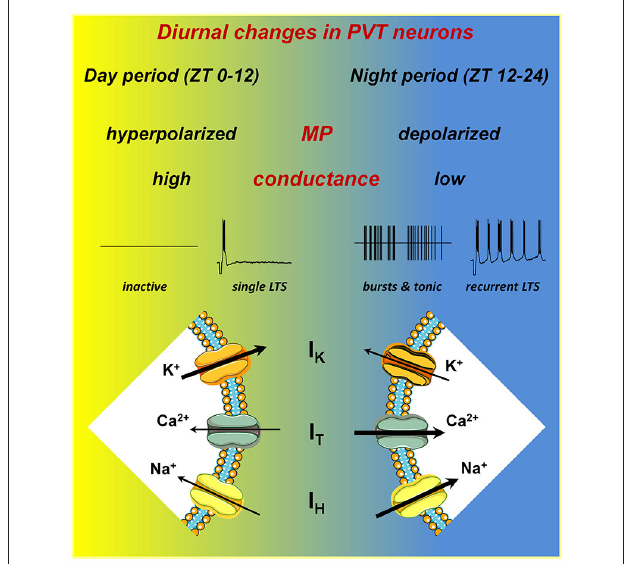
FIGURE 1 | PVT neurons express diurnal changes . A schematic illustrating the differences in intrinsic electrical properties of PVT neurons recorded in slices from different ZT periods. In night period slices, neurons have a more depolarized resting membrane potential (RMP), lower resting membrane conductance, in part owing to lower overall K + currents (I K ), and larger amplitude T-type Ca 2 + (I T ) and hyperpolarization-activated cation (I H ) currents. These changes result in increased spontaneous tonic and burst firing, and enhanced recurrent activity subsequent to generation of a low-threshold spike (LTS). For details, see Kolaj et al.